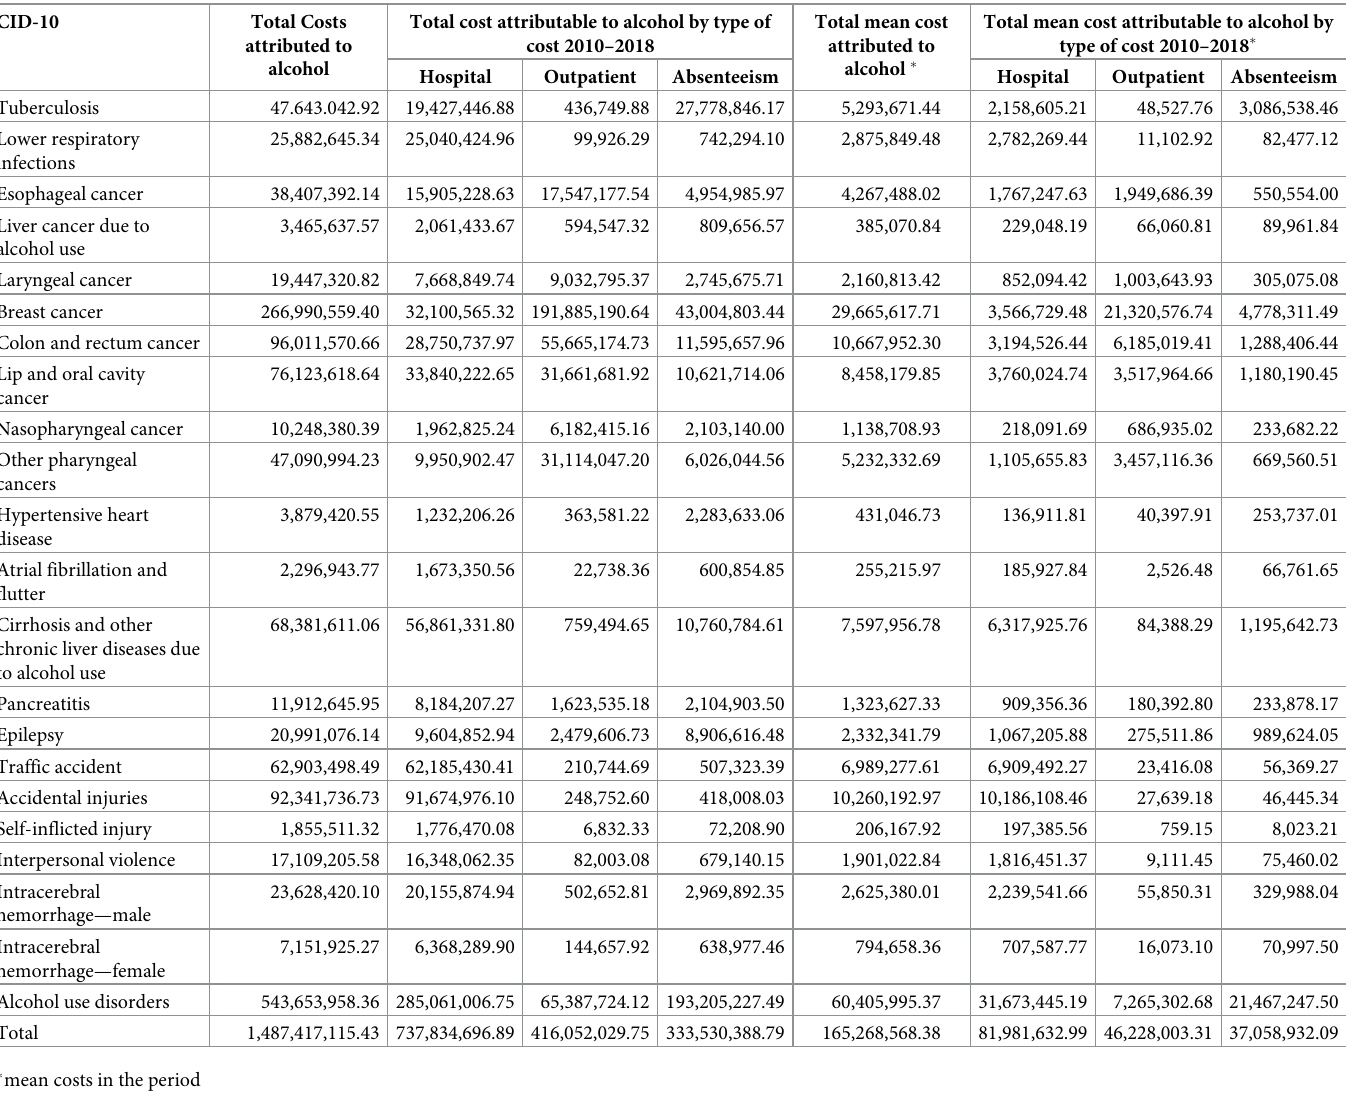
Table 4. Total and average costs attributable to alcohol by type of cost and ICD, Brazil, 2010 to